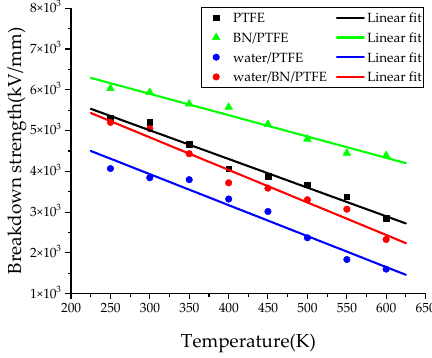
Figure 15. Breakdown strength versus temperature for four models.